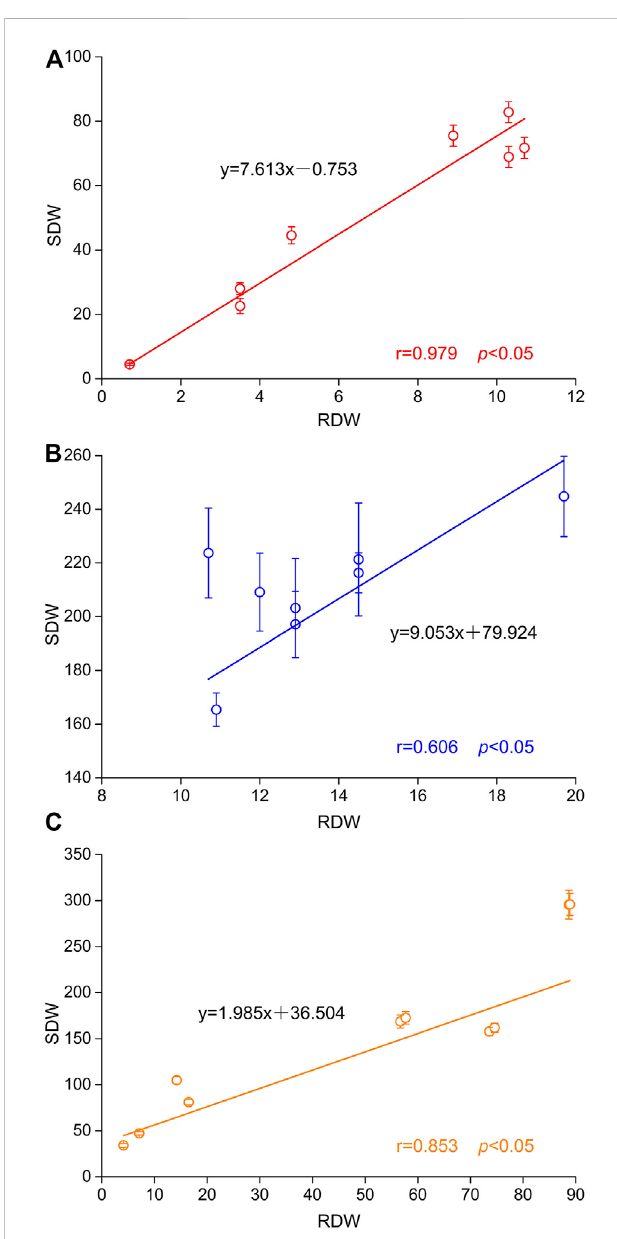
FIGURE 2 Relationships between rootdry weight(RDW)and shoot dry weight (SDW). (A) duringdrought- fl oodabruptalternation (DFAA)processinthe DFAA treatments; (B) at the mature stage in the DFAA treatments; (C) in the control treatments. Error bars represent standard deviations ( n =